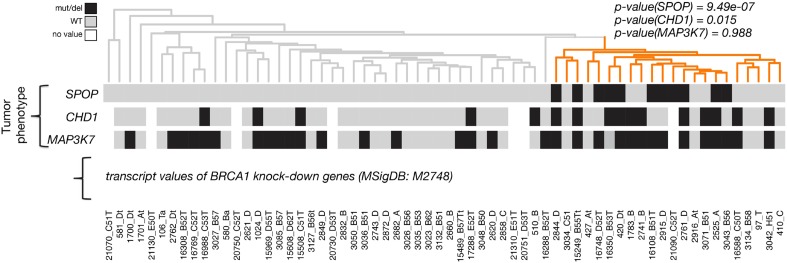
Dendrogram of human primary prostate cancer cases based on BRCA1 knockdown genes (MSigDB: M2748).Unsupervised clustering of RNA-seq data from human primary prostate cancer annotated for status of SPOP mutation, CHD1 deletion, and MAP3K7 deletion, performed on the BRCA-1 knockdown gene signature (M2748).